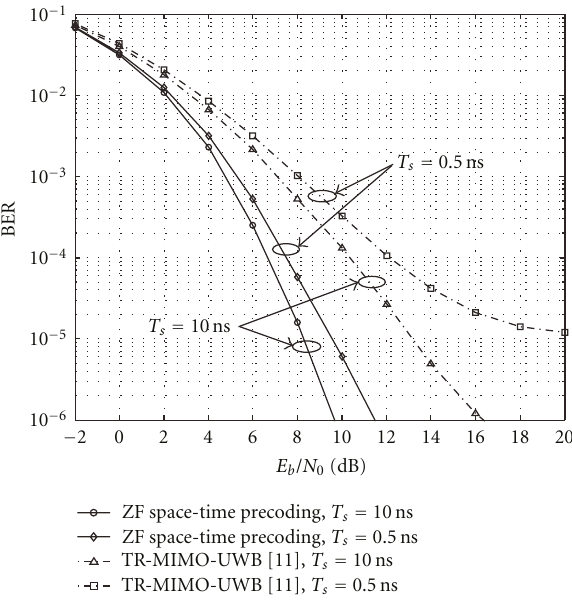
Figure 2: BER performance comparison between the proposed TR-MIMO-UWB system with space-time precoding and the TR- MIMO-UWB system. N t = 2, N r =